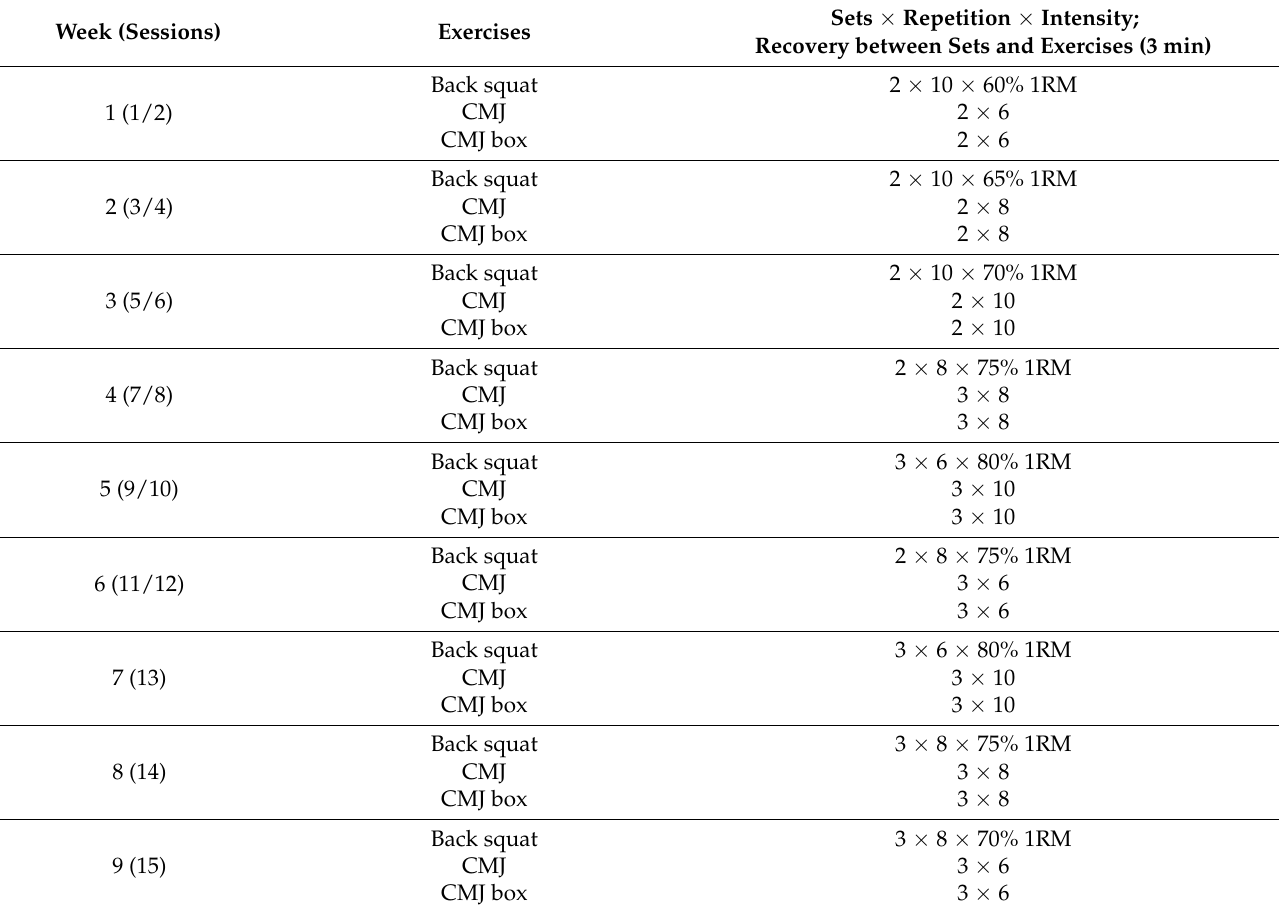
Table 1. Detailed resistance training conducted by the experimental